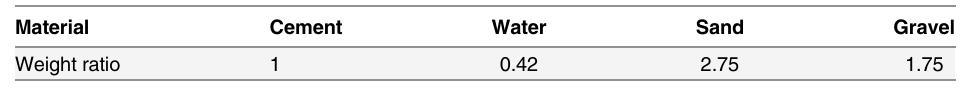
Table 1. Mix proportion. strength of specimens is presented in Table 2. The cement used in all mixes was normal Port- land cement, which corresponds to ASTM type II. In all specimens, confining steel bars with nominal diameter of 10 mm and yield stress of 300MPa were used. Three types of tilted-shaped angles consisting of L60, L80, and L100 with leg thicknesses of 6mm, 8mm, and 10 mm, respec- tively were tested. The tilted angles are 112.5 and 135 degrees measured with respect to the sur- face of the attached beam (see Fig 2). The angle lengths were 50 mm except for specimens 7 and 8 which had a length of 100mm. Details of tensile test on a typical steel angle are presented in Table 3.